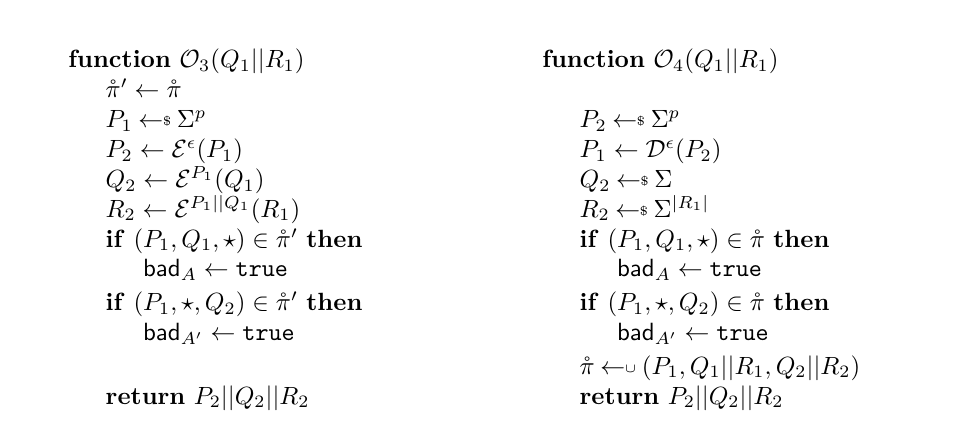
Figure 8: Oracles O 3 and O 4 are identical-until-bad. E is an ideal online permutation, with inverse D and internal table ˚ π . As with Figure 7, ˚ π 0 duplicates ˚ π to ensure tests are run against the input list, not an updated one. Inputs are at least 1 block long, parsed such that | Q 1 | = 1, and p ≥ 0 is a parameter. Oracle O 3 corresponds to calling an ideal online permutation with a randomised prefix. The output of Oracle O 4 is randomly sampled from Σ p +1+ | R 1 | , the set of strings p blocks longer than its input. It does not repeat an output until bad , and until bad the output of O 4 is indistinguishable from the output of a random permutation on p + 1 + | R 1 |